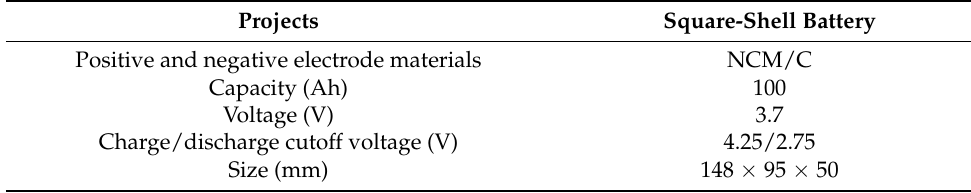
Figure 1. Simulation experiments of ISC faults within the battery module.